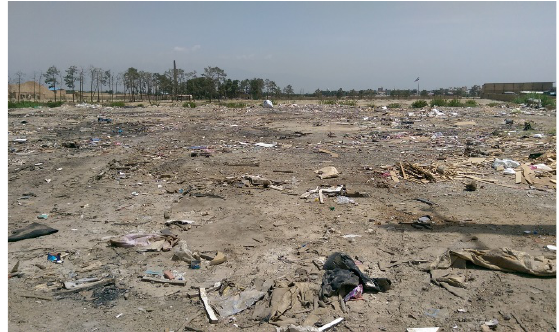
Figure 8. Pollution of vacant grounds in the region Region parks: There are no specified parks in the area. The lack of urban open space in the region has greatly affected the appearance of the neighborhood and created a bad condition. Most of the vegetation was created by residents and are irrigated by surface runoff, sewage, and especially, drinking